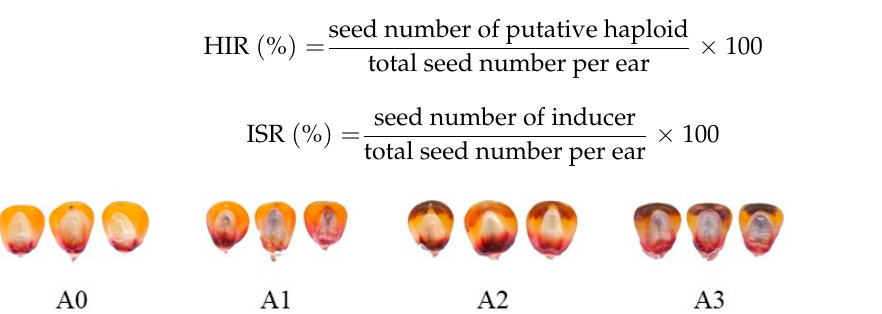
Figure 3. R1-nj anthocyanin marker expressed on the endosperm and embryo of dried tester seeds. From left to right: ( A0 ) Out crossed or self-pollinated; ( A1 ) Lethal; ( A2 ) Putative haploid; ( A3 ) Puta- tive diploid.